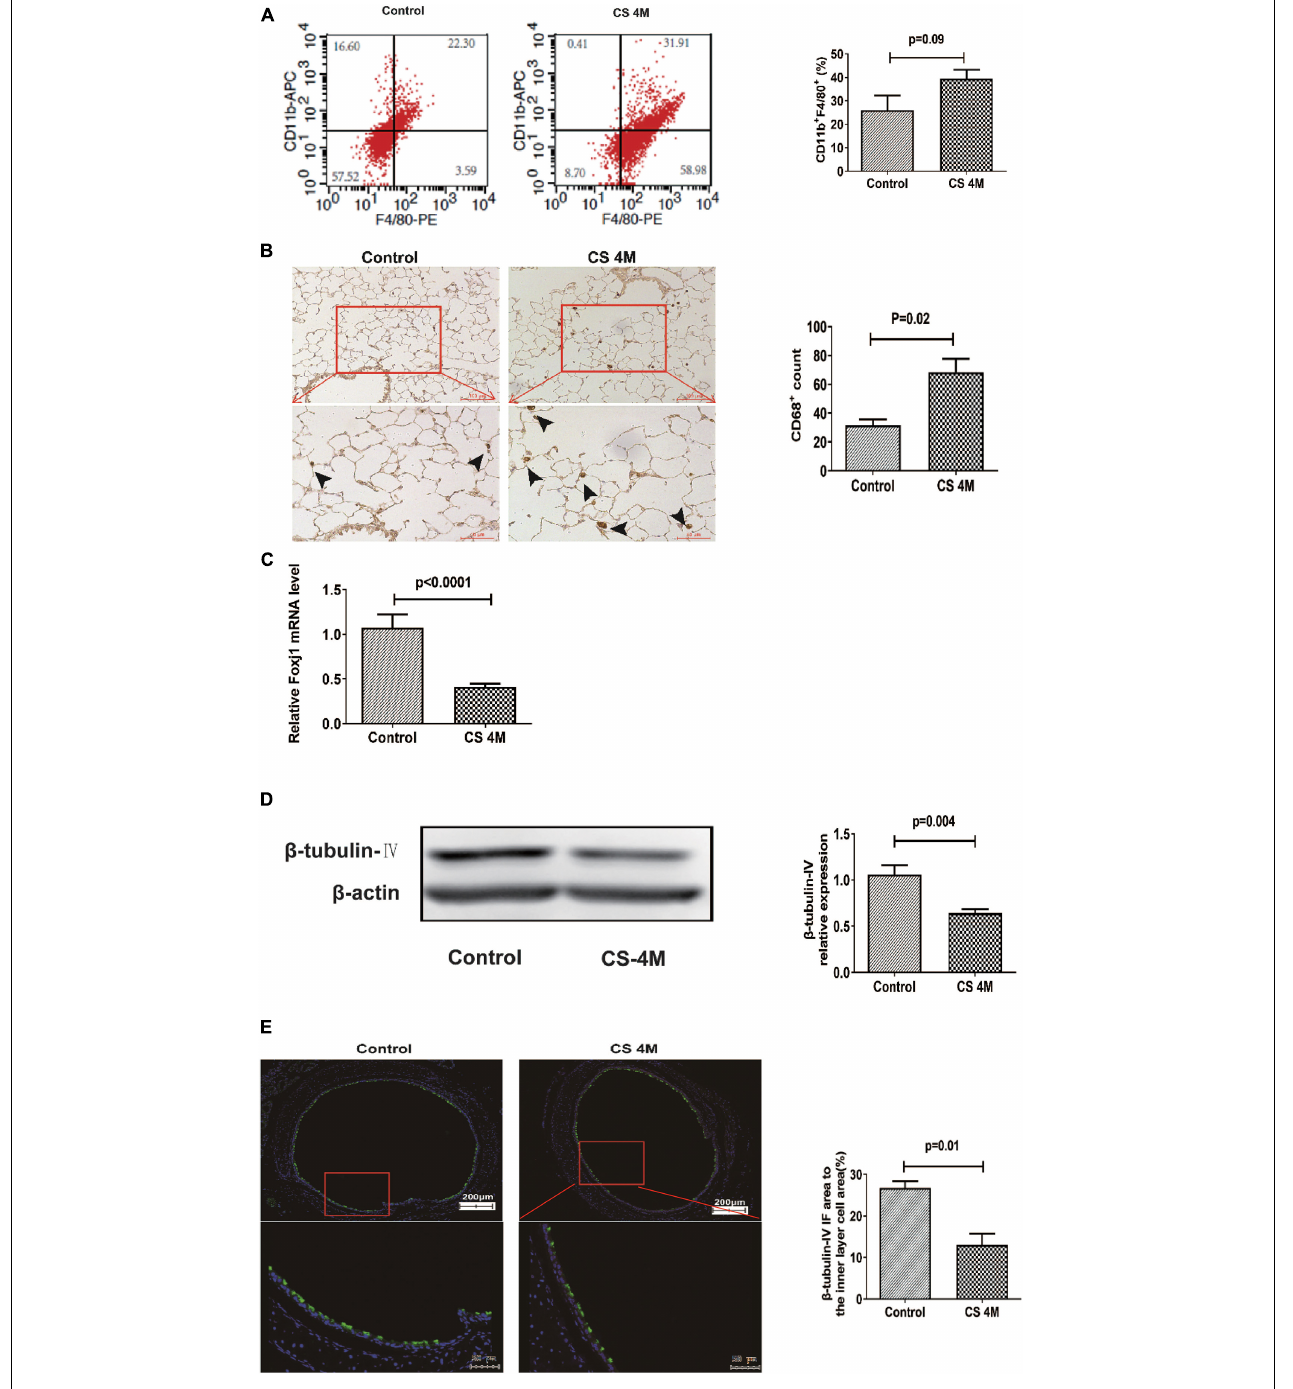
FIGURE 3 | The changes of macrophages in the lung and β -tubulin-IV in the airway of mice after chronic CS exposure for 16 weeks. (A) The percentage of CD11b + F4/80 + macrophages in the lung detected by FACS in the control group and the CS4M group ( n = 4, CS4M = cigarette smoke exposure for 16 weeks). (B) The CD68 + macrophages in the lung detected by IHC staining in the control group and the CS4M group (the upper panel bar is 100 µ m, the bottom panel bar is 50 µ m, black arrow indicates CD68 + macrophages, n = 6). (C) The relative expression of foxj1 mRNA in the airway of mice was determined by qRT-PCR after chronic CS exposure for 16 weeks ( n = 6). (D) The relative levels of β -tubulin-IV protein in the airway of mice were quantitated by densitometry and normalized to β -action after chronic CS exposure for 16 weeks ( n = 6). (E) The β -tubulin-IV protein levels in the airway epithelium of mice stained by IF in the control group and the CS4M group (the upper panel bar is 200 µ m, the bottom panel bar is 50 µ m, nuclear was dyed with DAPI, and cilia was dyed with FITC, n = 4). The ratio of cilia area to the inner layer cell area in the control group and the CS4M